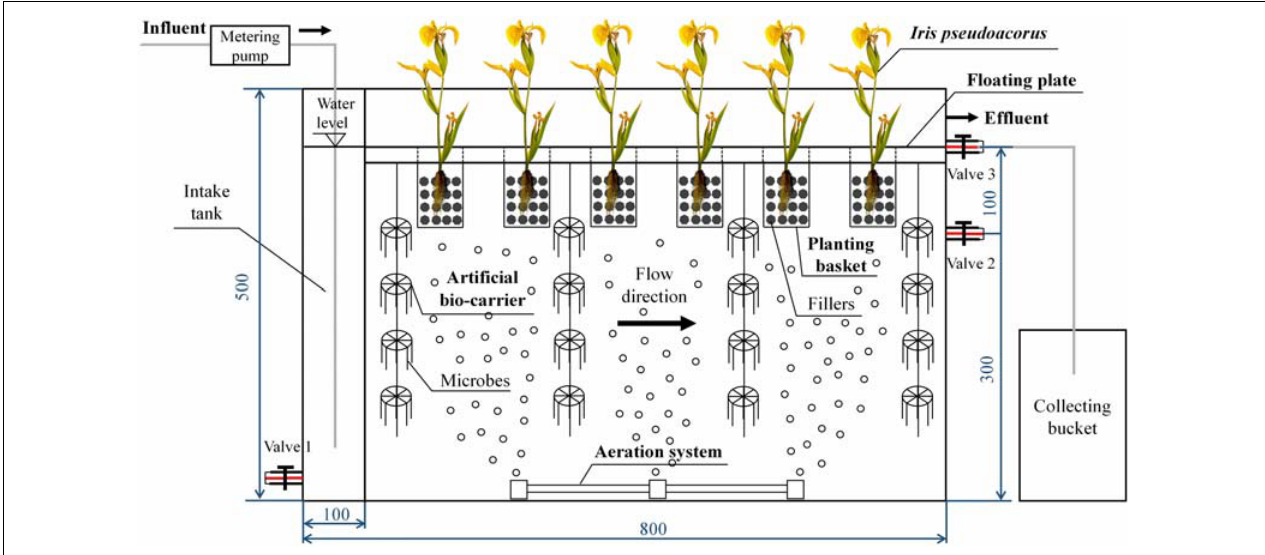
FIGURE 1 | Structure of the integrated floating bed. The integrated floating bed consisted of a floating bed system, an aeration system, a water inlet system, and an effluent system. The floating bed system consisted of four parts: plants, floating plate, planting baskets with fillers, and artificial bio-carriers.